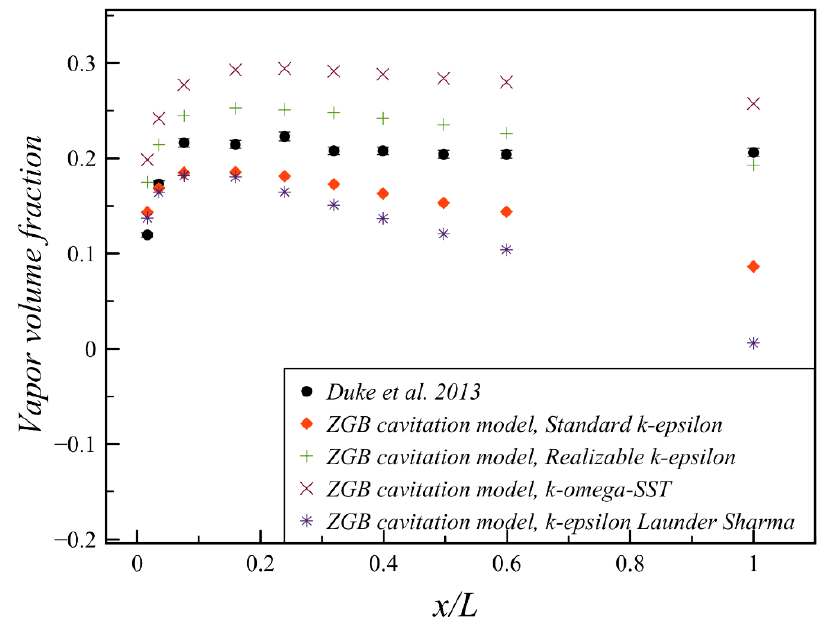
Figure 6. Comparison of predicted total vapor volume fraction, obtained from four turbulence models, with experimentally measured total vapor volume fraction across the nozzle at different axial positions along the nozzle. Error bars in the experimental data show uncertainty of around 2% [15].